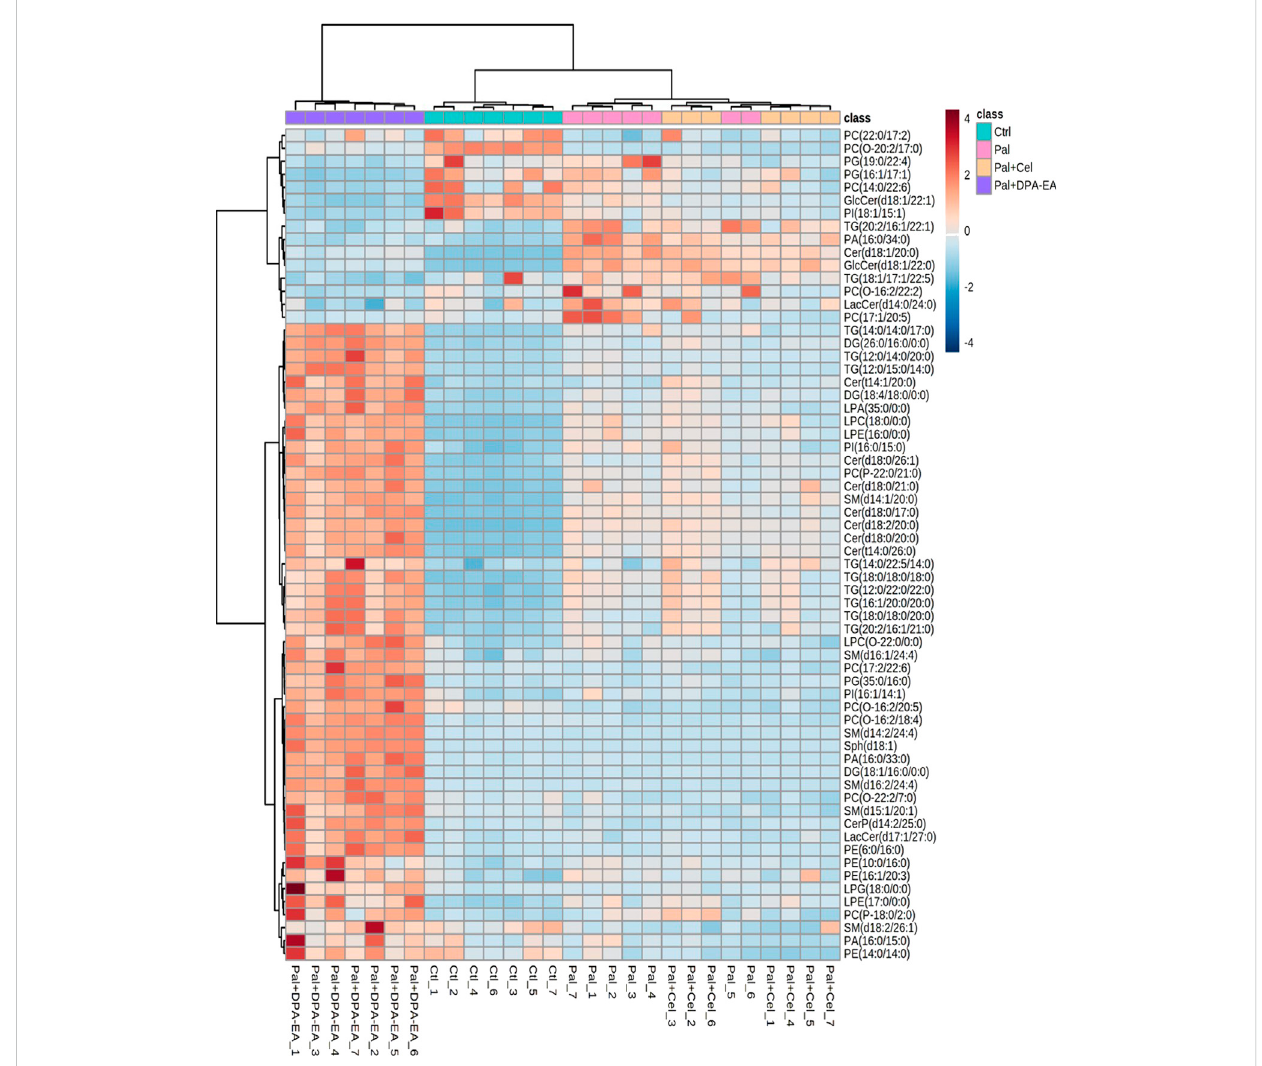
FIGURE 7 Heatmap of DELs only in the Pal + DPA-EA vs. Pal model, not in the Pal + Cel vs. Pal model, selected with the fold change cutoff of FC > 1.6 or FC < 0.5 as upregulated and downregulated, respectively. Red and blue indicate increased and decreased lipids in each group, respectively.